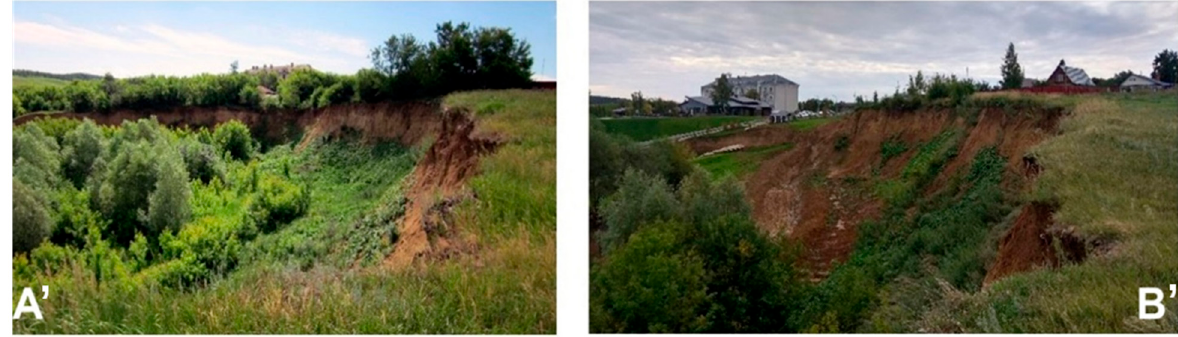
Figure 4. Views on the landslide at site 2 in 2003 (( A )—front view, ( A’ )—lateral view) and in 2019 (( B )—front view, ( B’ )—lateral view).